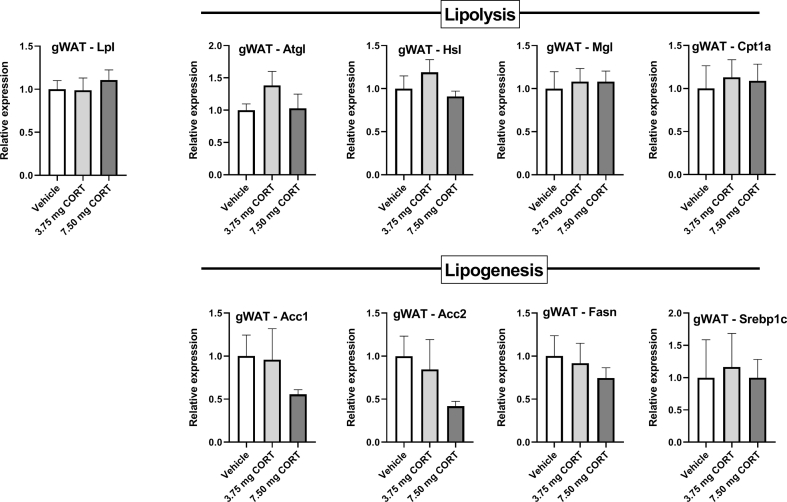
Flattening of corticosterone rhythm does not influence expression of genes involved in lipolysis and lipogenesis in gWAT. mRNA expression of lipoprotein lipase (Lpl) and genes involved in lipolysis and lipogenesis in gonadal white adipose tissue (gWAT) of female APOE∗3-Leiden.CETP mice implanted with vehicle, 3.75-mg or 7.5-mg corticosterone (CORT) pellets.